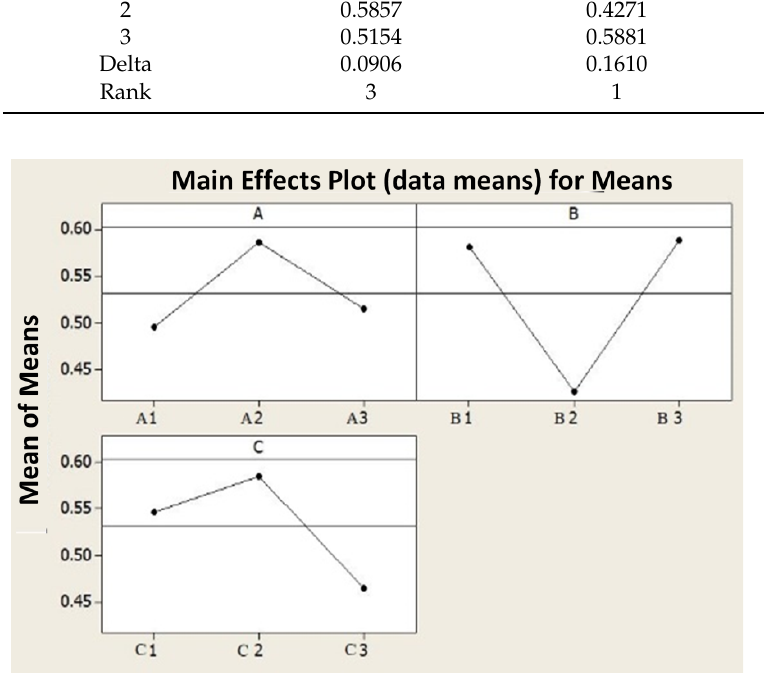
Figure 6. Graph for level mean of GRG values.